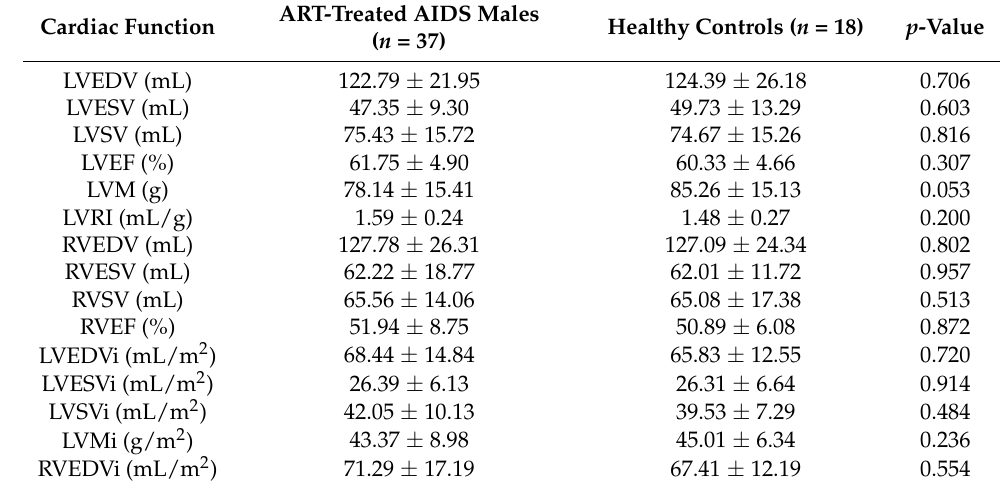
Table 2. CMR characteristics of ART-treated AIDS males and healthy